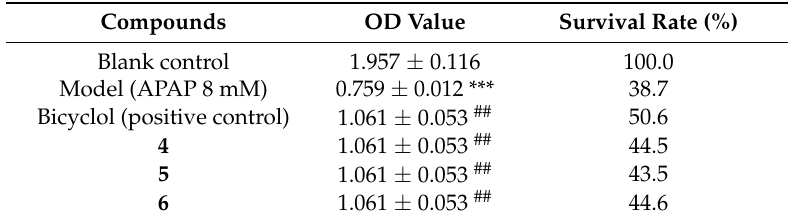
Table 1. Hepatoprotective effects of compounds 4 – 6 (10 µ M) on the survival rate of HepG2 cell injured by